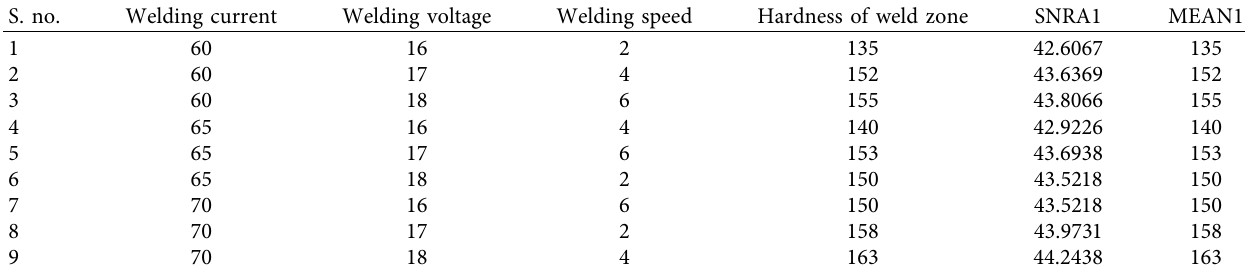
Table 5: Hardness of welded zone reading and S/N ratio.